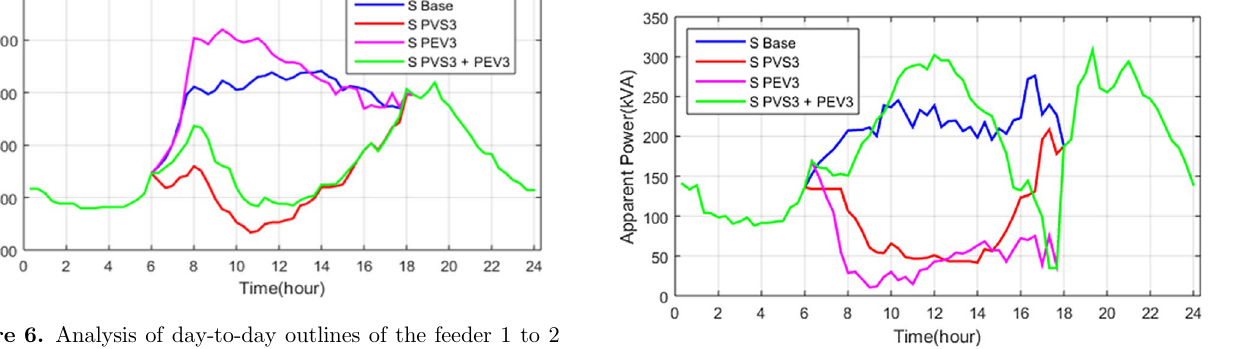
Figure 9. Analysis of day-to-day outlines of domestic load at the transformer 3 during